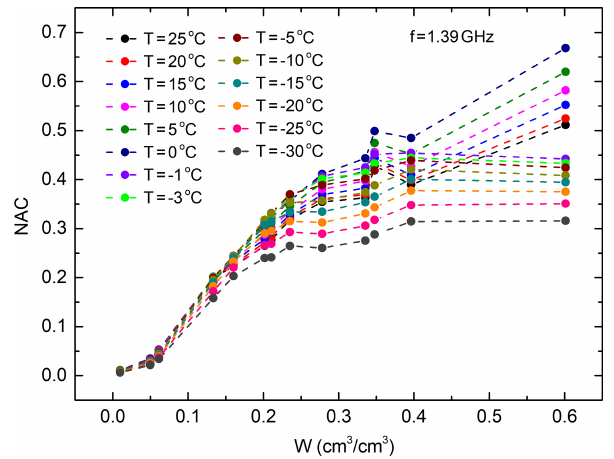
Figure 7. Normalised attenuation coefficient (NAC) for sample no. 6 (TM) as a function of soil sample moisture ( W ) for various temperatures at a frequency of f =